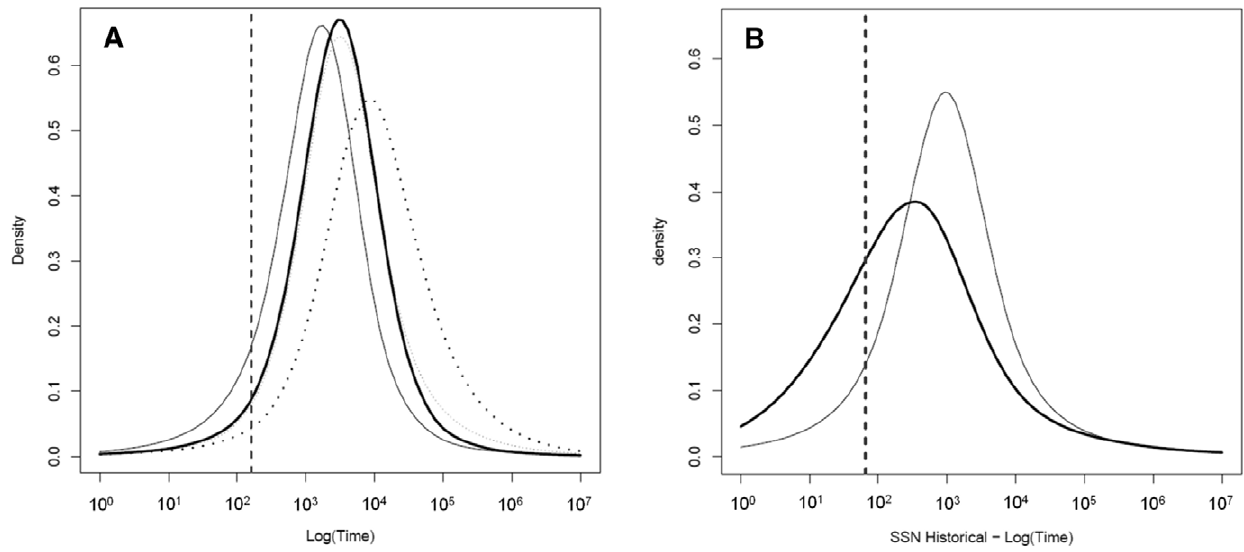
Figure 5. MSVAR results: time of population decline. Posterior distribution of time of decline ( T ) for the linear (thin line) and exponential (thick line) models. A) Time (in years before present) for the contemporary SSN (solid lines) and NW (dashed lines). B) Time for the historical SSN. The vertical dotted line shows the approximate time of the European settlement of California ( , 1850) relative to the age of each of the samples.